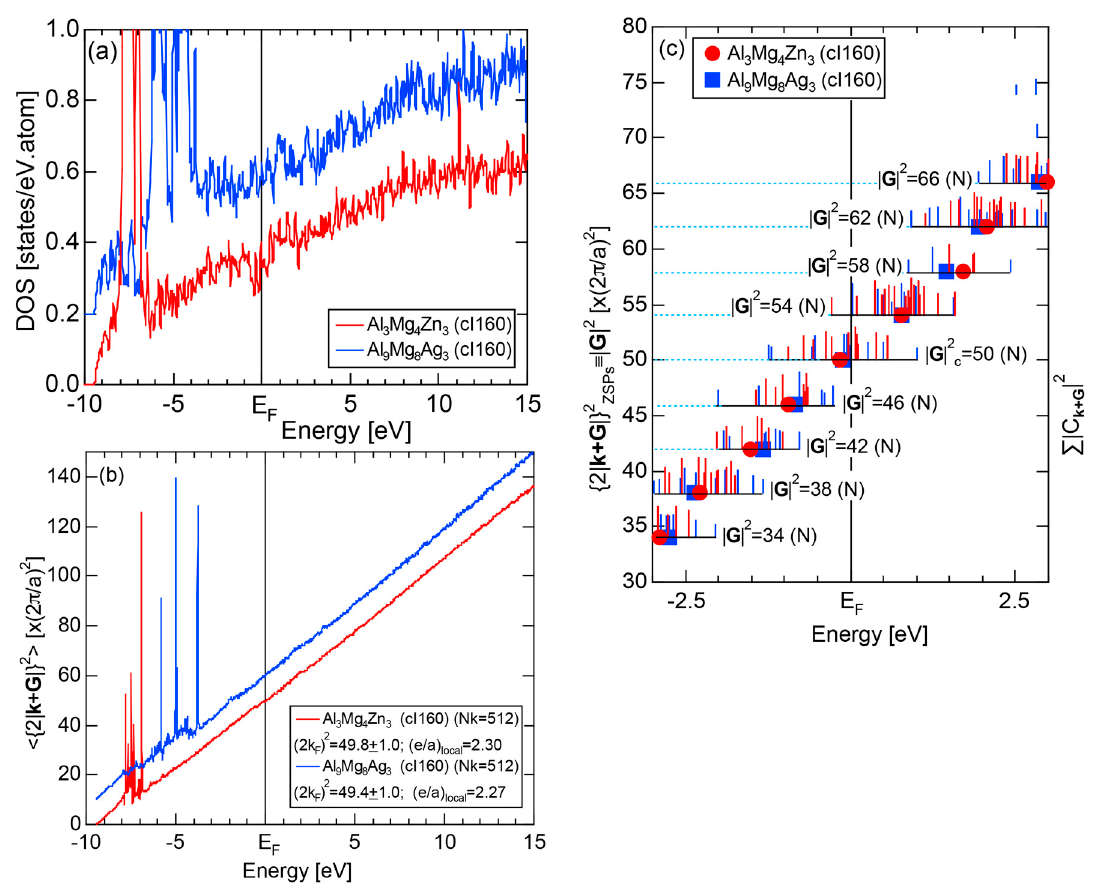
Figure 39. ( a ) Total-DOSs; ( b ) Hume-Rothery plots and ( c ) FLAPW-Fourier spectra at symmetry points N of the bcc Brillouin zone for Al 3 Mg 4 Zn 3 (cI160) (red) and Al 9 Mg 8 Ag 3 (cI160) (blue) [11,13]. The FLAPW-Fourier spectra at symmetry points N for the two RT-type 1/1-1/1-1/1 approximants Al 3 Mg 4 Zn 3 (cI160) and Al 9 Mg 8 Ag 3 (cI160) are depicted in Figure 39c. The center of gravity